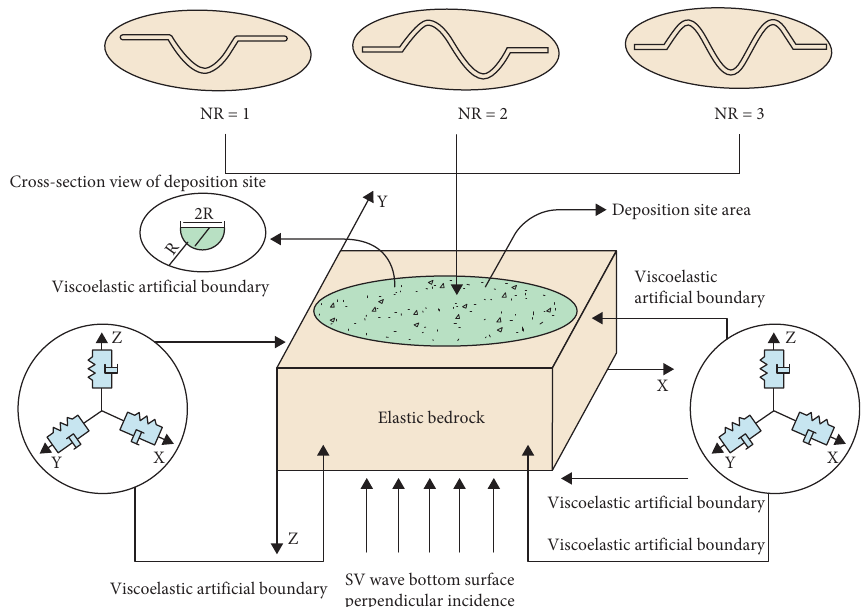
Figure 3: Model diagram (NR indicates the number of meanders in a bent sedimentary valley).